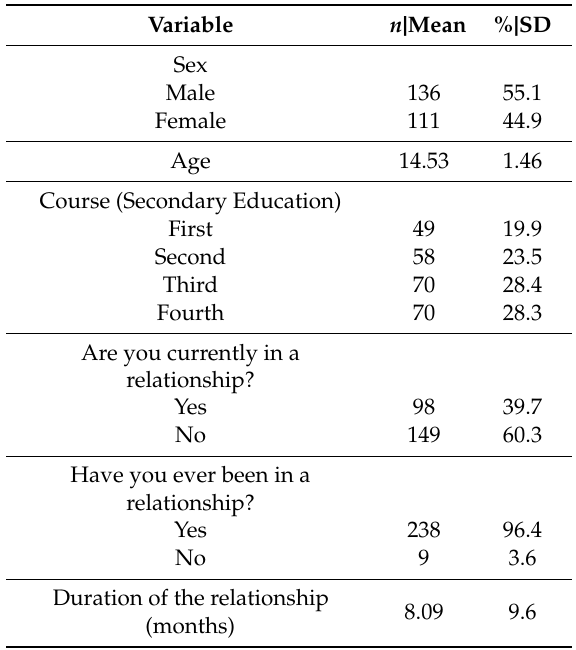
Table 1. Sociodemographic characteristics of the